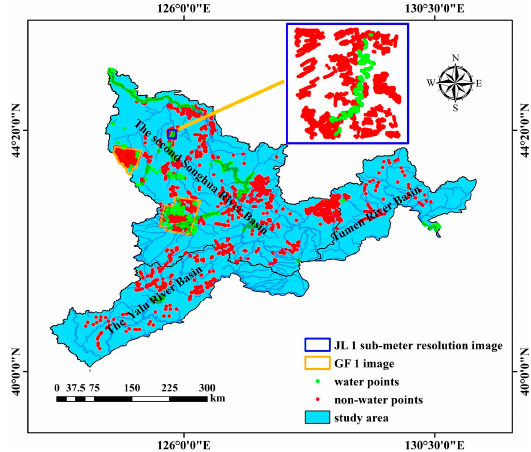
Figure 2. Sample